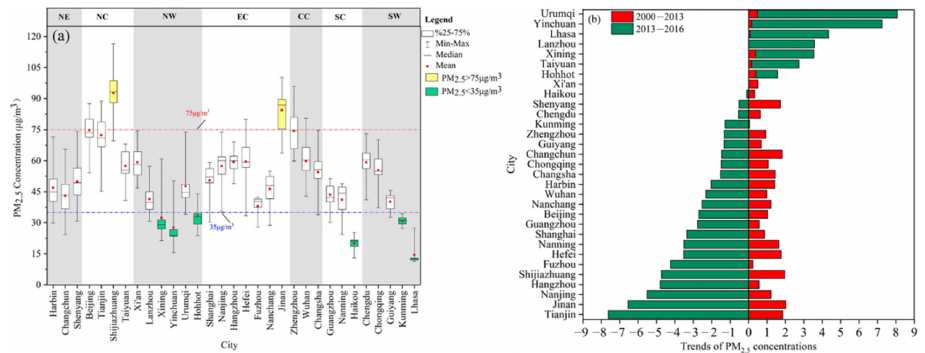
Figure 2. Annual average PM 2.5 concentration ( a ) and ( b ) the trends of PM 2.5 concentrations in pro- vincial capital cities from 2000 to 2016. provincial capital cities from 2000 to